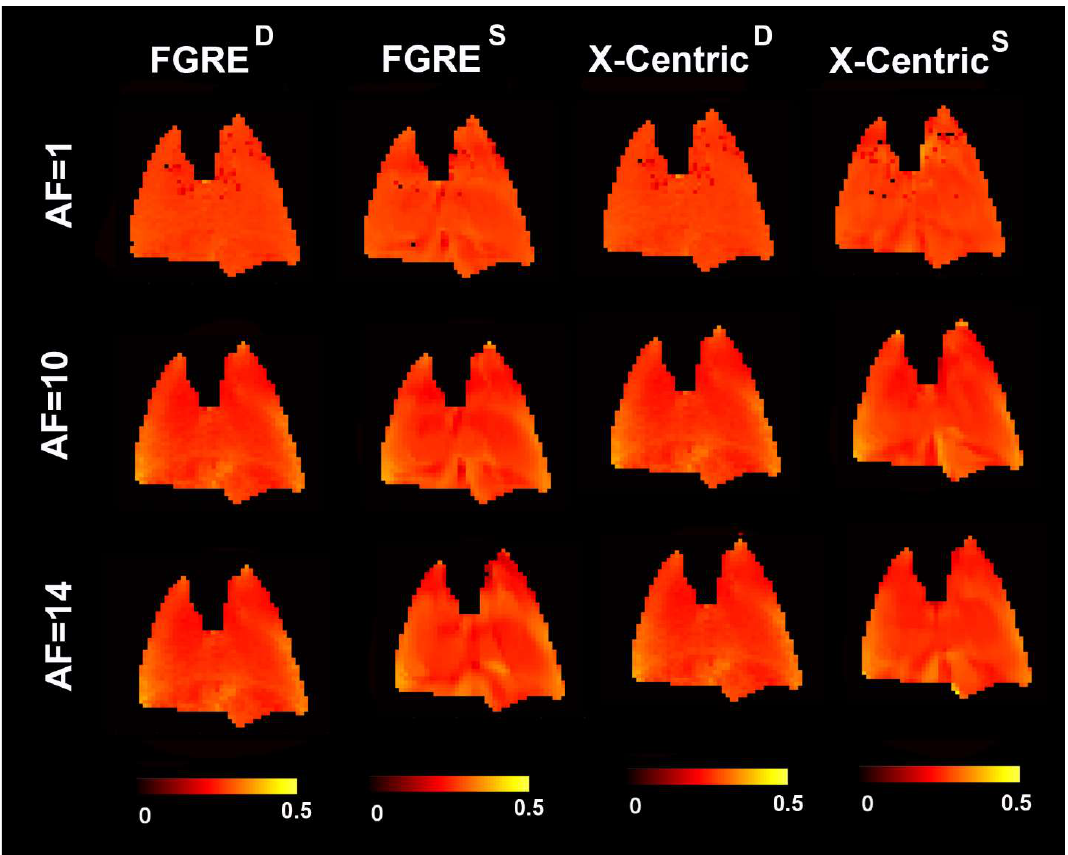
Figure 4. Representative 3 He MRI-based fractional ventilation maps generated by using the Deninger method ( D ) and the SEM ( S ) from normal animal using two different imaging approaches (FGRE and X-Centric). The top panel shows fractional ventilation maps calculated for the original fully sampled k-space. The middle and bottom panels show the maps generated for the retrospectively under-sampled data mimicking AF = 10 and 14, correspondingly.